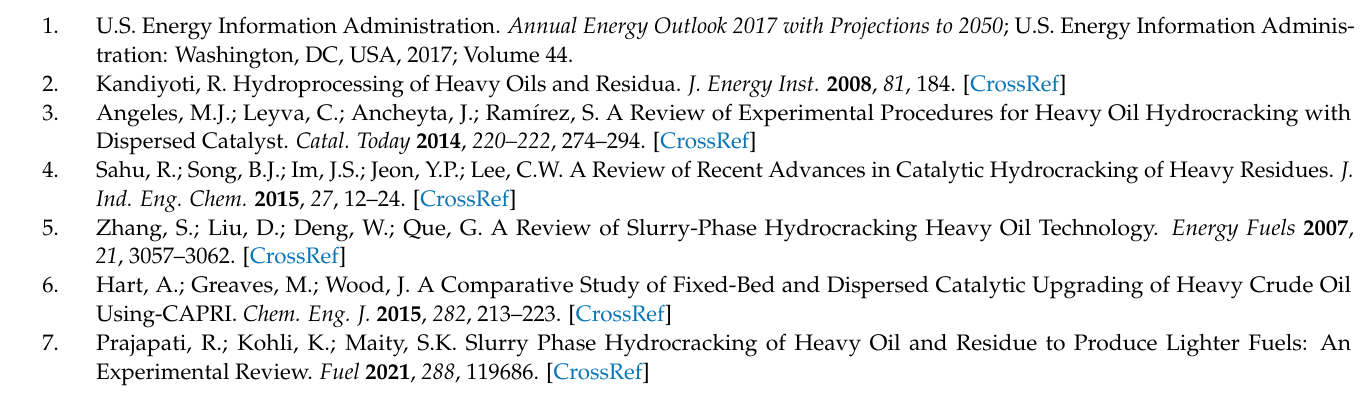
Figure S2: Differential thermogravimetric (DTG) and Differential heat flow profiles of (a) Ni-TBC[6] and (b) Co-TBC[6]; Figure S3: Mechanism of in situ sulfidation to form the active metal sulfide from metal-based calixarenes; Table S1: Features and Advantages Offered by Calixarene [11]; Table S2: Physical and chemical properties of the vacuum gas oil (VGO); Table S3: Temperature of peaks in DTG; Table S4: Characteristic peaks in DSC; Table S5: Properties of the Commercial Hydrocracking Catalyst